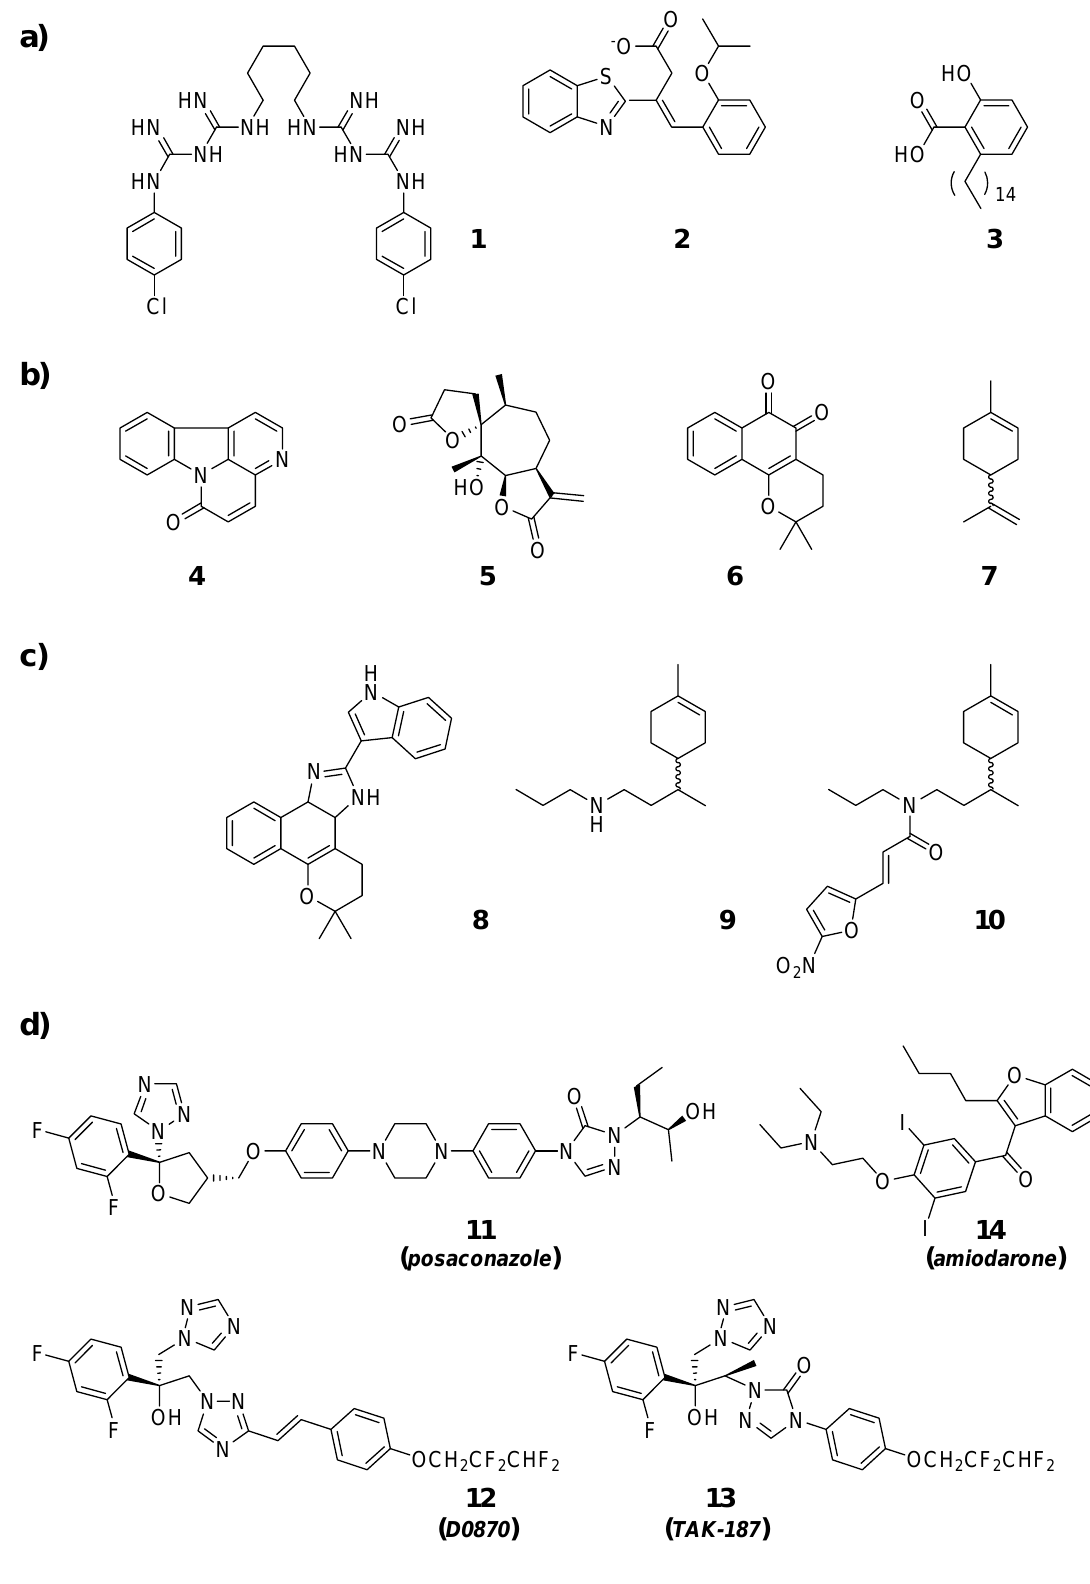
Figure 2. (a) Chemical structures of selected T. cruzi -enzymatic inhibitors. (b) Chemical structures of selected natural products with anti- T. cruzi activity. (c) Examples of medicinal chemistry based on natural products. (d) Chemical structures of examples of drug-profiling strategy in Chagas’